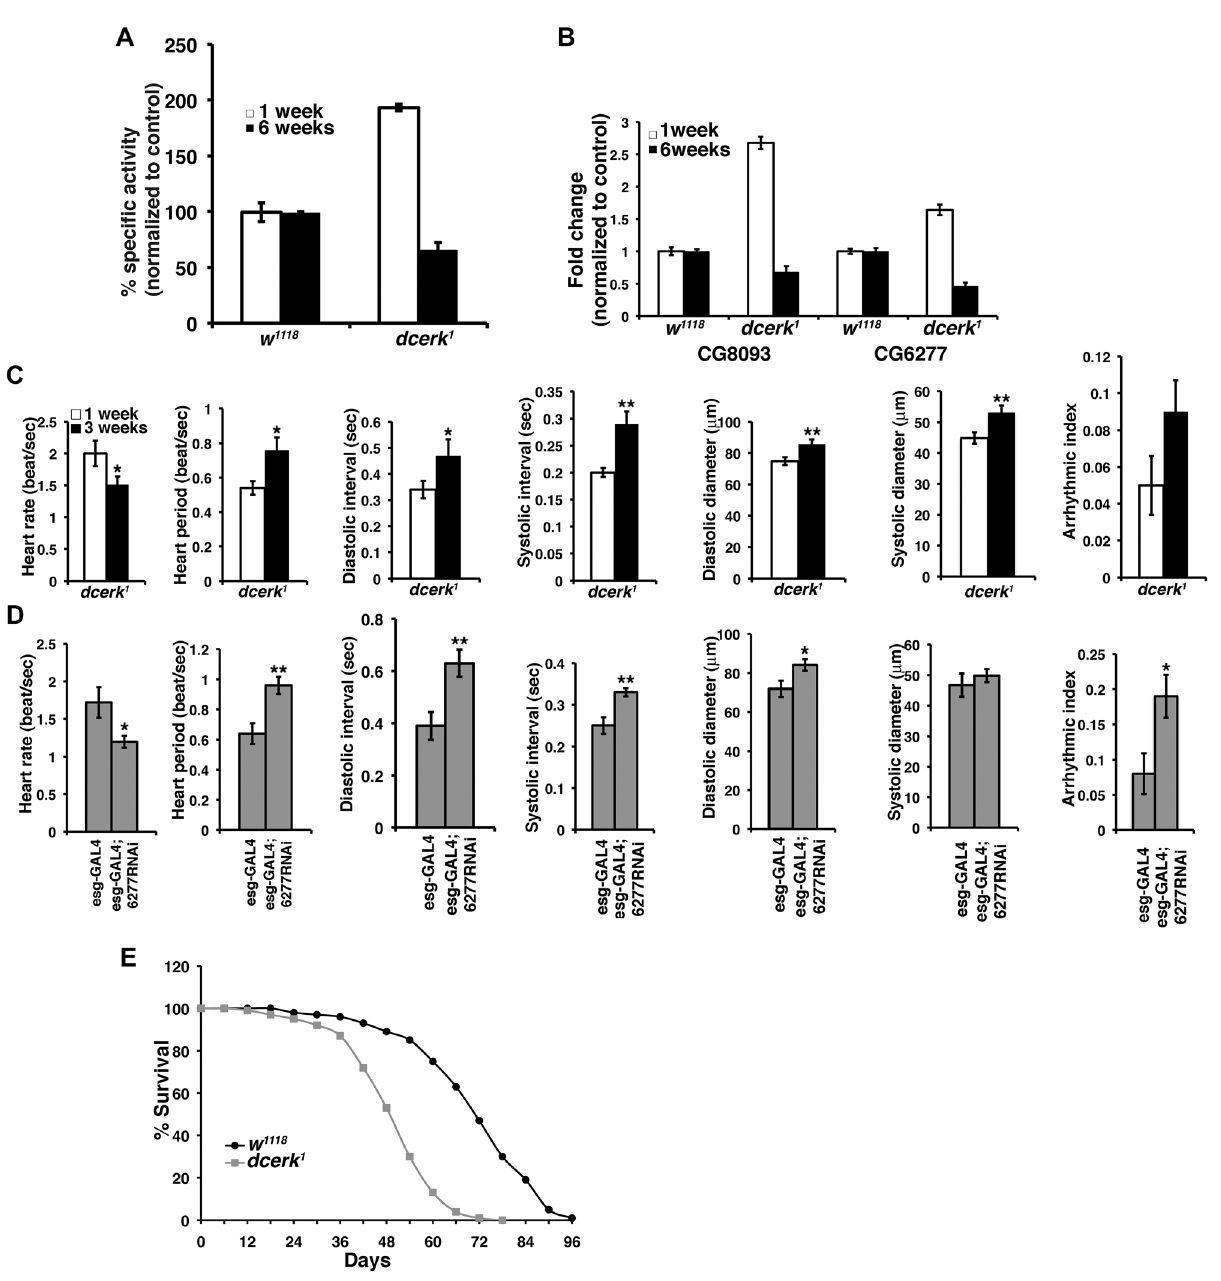
Figure 6. Failure of adaptive mechanisms leads to cardiac dysfunction and reduction in adult life span of dcerk 1 . (A). Measurement of Pglym enzyme activity in young (1 week) and aged (6 weeks) w 1118 and dcerk 1 flies shows a significant decrease in activity in older dcerk 1 . (B). Comparison of transcript levels of CG8093 and CG6277 by QPCR in 1week and 6 week old flies, reveals decrease in their transcripts in aged dcerk 1 flies. (C). Comparison of several cardiac performance indices in 1 and 3 week old esgGAL4 dcerk 1 flies reveals progressive decline in heart function with decreased heart rate, increased heart period and dilated heart chamber. n=15, bar represents standard error of mean and statistical significance was determined using Student’s t test; * denotes P , =0.05-0.01, ** is P , =0.01-0.001 is and *** denotes P , =0.001-0.0001. (D). Knockdown of CG6277 in 3 week old wild type flies also shows decreased heart rate, increased heart period, dilated heart chamber and arrhythmia. n=10, bar represents standard error of mean and statistical significance was determined using Student’s t test; * denotes P , =0.05-0.01, ** is P , =0.01-0.001 is and *** denotes P , =0.001-0.0001. (E). dcerk 1 have reduced adult life span compared to w 1118 flies. The survivorship curve of dcerk 1 and w 1118 represents data from 600 flies in